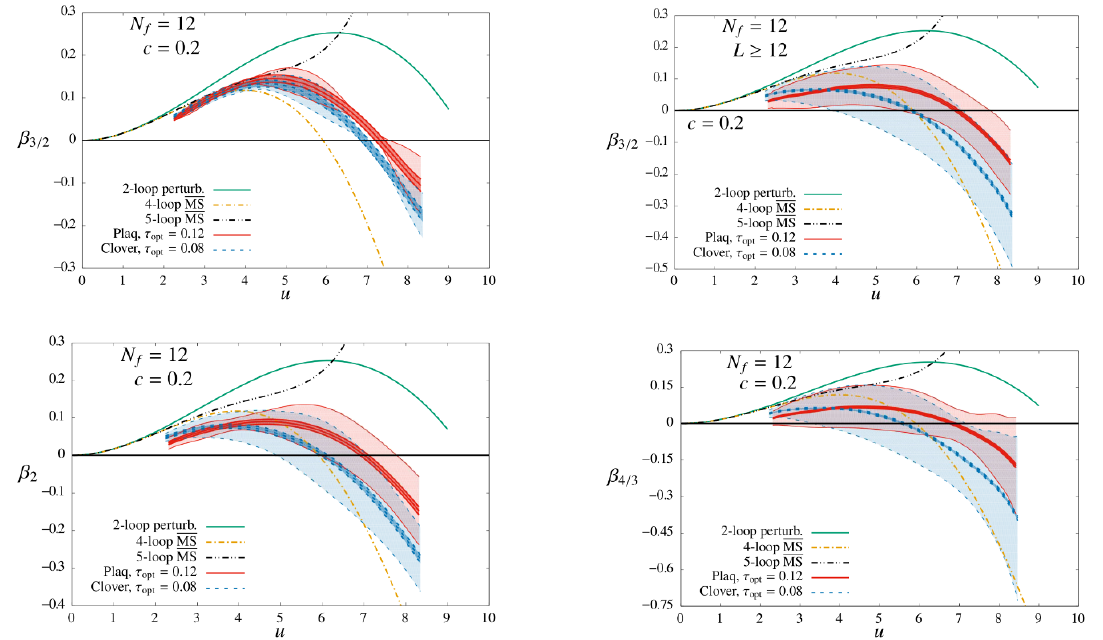
Figure 9 . Continuum-extrapolated discrete (cid:12) function for c = 0 : 2, plotted in the same style as (cid:12)gure 4. In the top row the scale change is s = 3 = 2, with L (cid:21) 16 for the top-left plot (as in the body of the paper). In the top-right plot, including L (cid:21) 12 dramatically increases the systematic uncertainties, and leads to questionable plaquette-based results (cid:12) s < 0 for all couplings we can access. Similar behavior persists in the bottom row of plots considering s = 2 (left) and s = 4 = 3 (right), both of which necessarily include L (cid:21) 12. As always, all errors are computed exactly as in (cid:12)gures 4 and